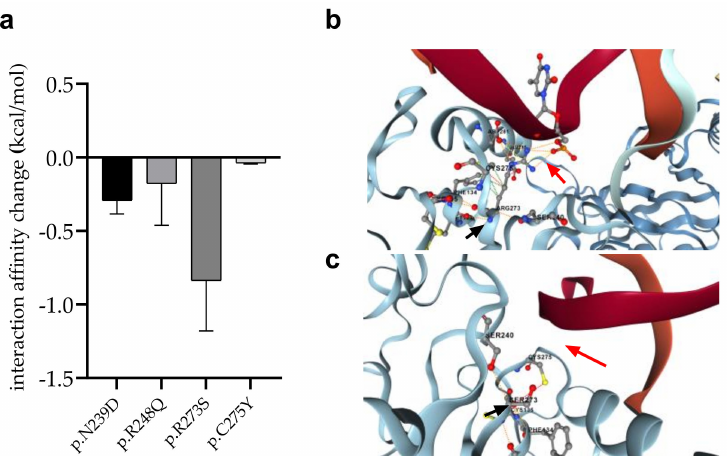
Figure 9. Changes of interaction between p53 and DNA in response to mutations. ( a ): Error bars indicate SD of the values obtained from the analysis of three different structures. ( b ): DNA-protein interaction (red arrow) between p.R273 (black arrow) wild-type protein and DNA, ( c ): Absence of DNA-protein interaction (red arrow) between p.R273S mutant (black arrow) protein and